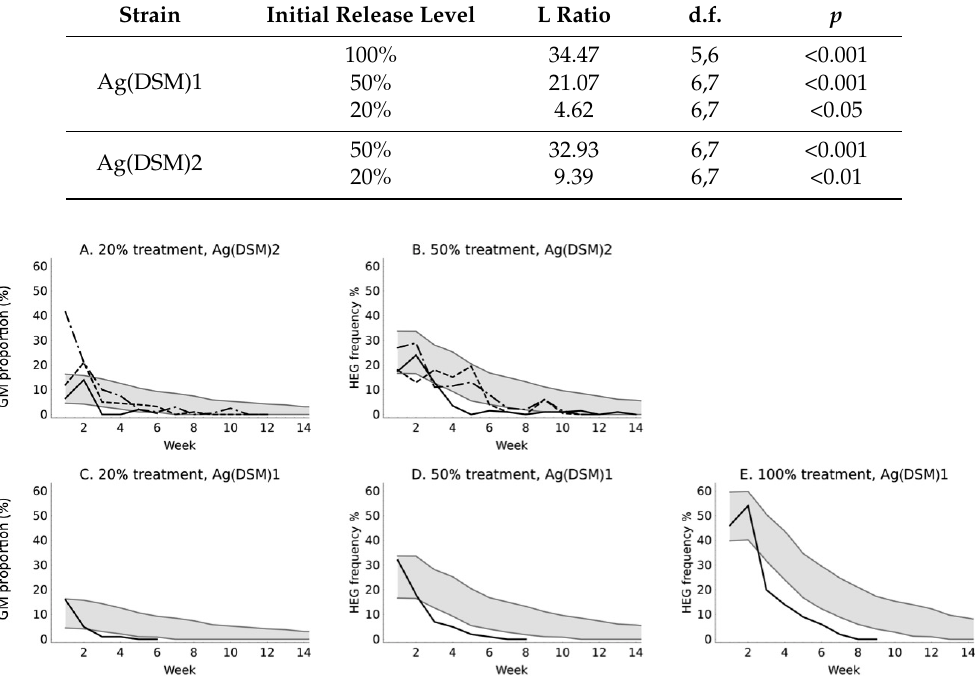
Figure 5. Model predictions and observations of transgene frequency in unselected populations. The modeled frequency expected of the transgene in the experimental populations when seeded at different frequencies and the observations for either GMM line. The gray bands show the 95% central quantile intervals of the model trajectories. The dashed and solid black lines represent the experimental results for three replicates of two treatments with Ag(DSM)2 ( A , B ) and the single experiments at three treatment levels with Ag(DSM)1 ( C – E ).